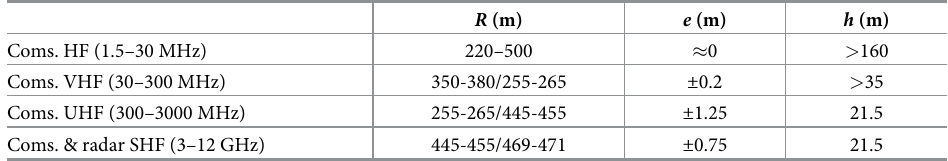
Table 5. Radius, flight level and measurement uncertainty for F-100’s class Spanish Navy frigates’ antenna.